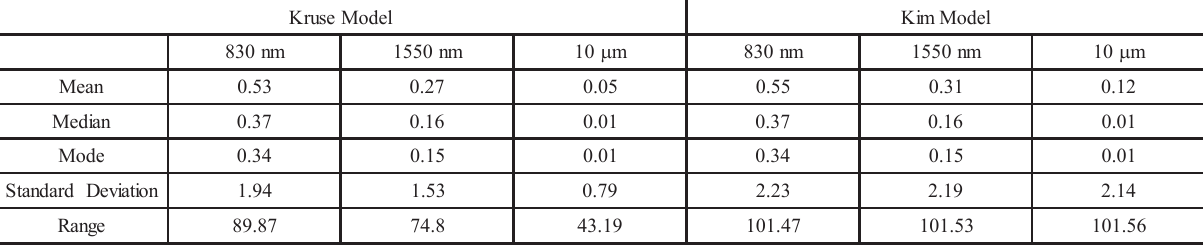
TABLE 5. DESCRIPTIVE STATISTICS OF ESTIMATED OPTICAL ATTENUATION FOR THE